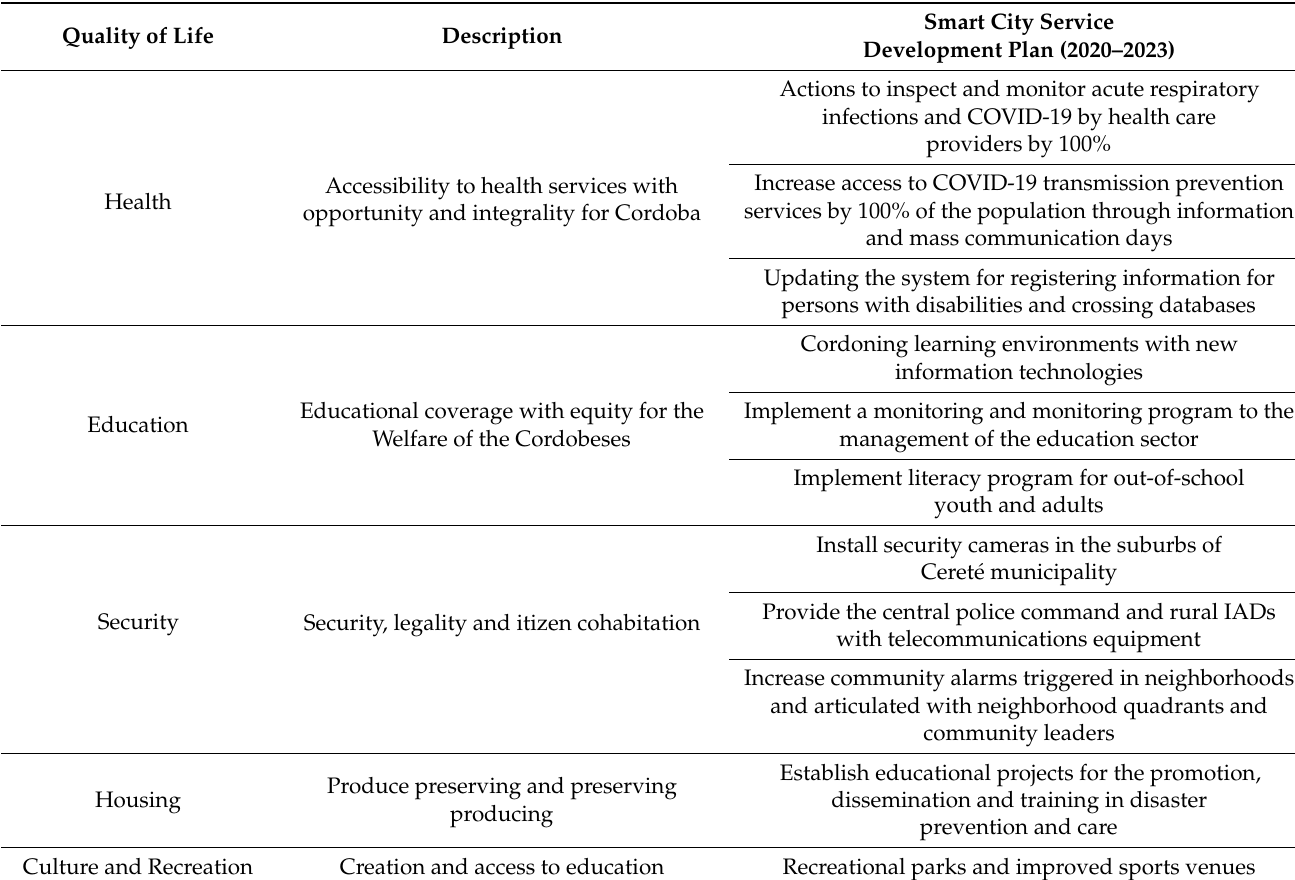
Table 7. Step 1: Select smart city